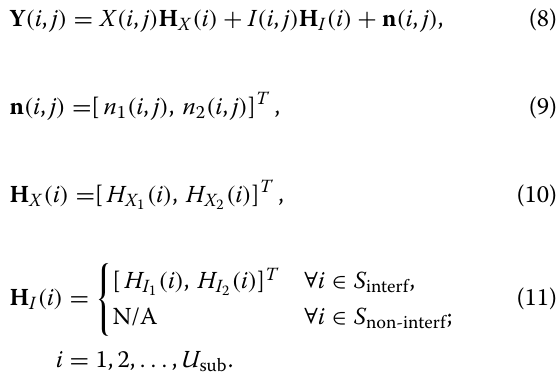
After FFT, the received signal vector Y on i th subcar- rier of j th WiFi OFDM symbol with the desired WiFi and interfering ZigBee samples X ( i , j ) and I ( i , j ) ,